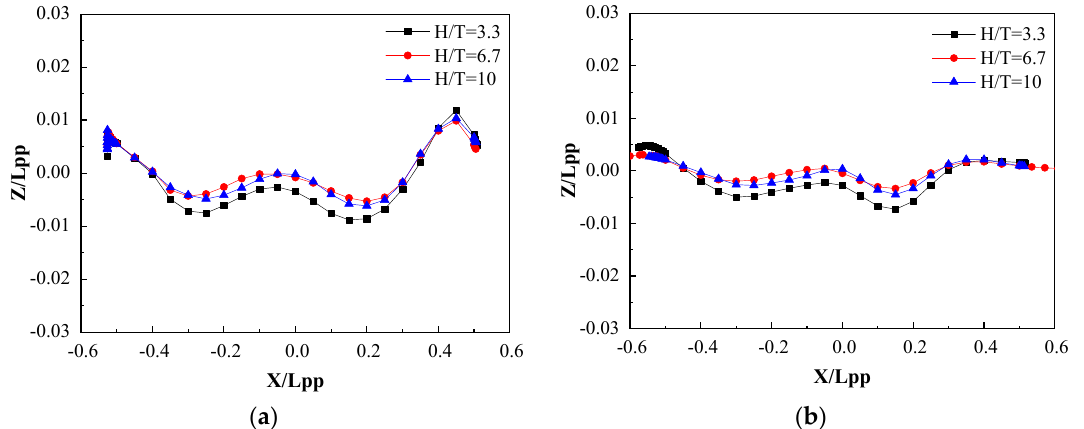
Figure 15. The full-scale wave profiles at different water depths: ( a ) on the hull surface and ( b ) on the Y = 0.1509 Lpp section.